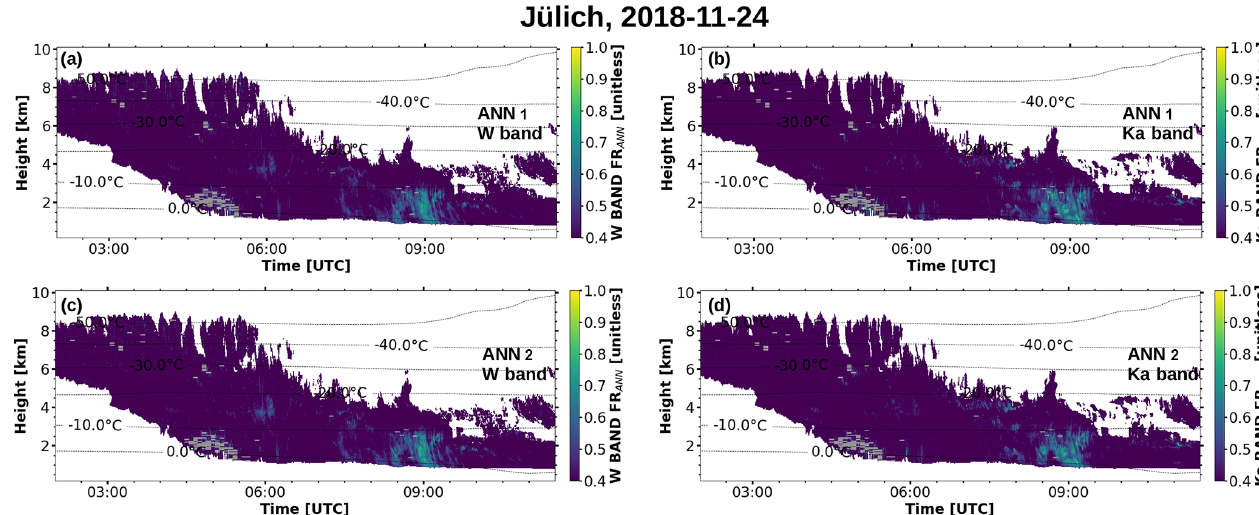
Figure 6. Predicted riming during the case on 24 November 2018 by ANN 1 and 2 using W-band moments (a, c) and Ka-band moments (b, d) as input features. The ANNs were applied only to those parts of the cloud which were classified as containing ice or ice and liquid by the CloudNet algorithm. Pixels with EDR above the threshold of 10 − 3m 2 s − 3 are masked in gray.